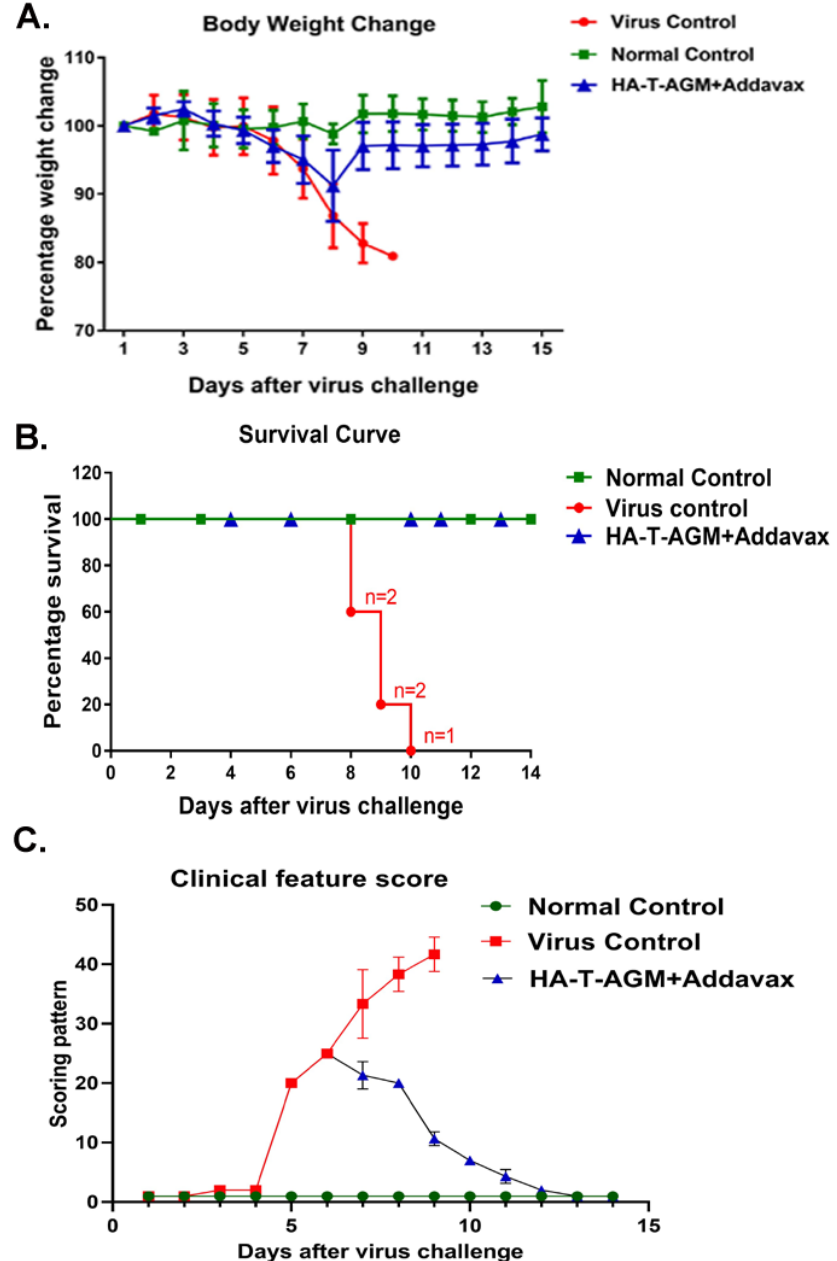
Figure 5. Protection by HA-T-AGM antigen against virus challenge. ( A ): Weight change in immunized mice followed for 14 days post virus challenge (Inf A/Puerto Rico/8/34 (PR8)), and comparison made to the immunized vs. non-immunized (virus control) group along with normal naïve control mice group. ( B ): Survival curve showing the number of dead mice after virus exposure with days passing. ( C ): The animals were scored from day 1 to day 14 after the virus challenge. The scoring scheme followed from 1 – 10 where 1 shows NAD (No abnormality), 2 was D (Dull), 3 was MP (Mild piloerection), 4 was PE (Piloerection), 5 was RFD (Reduction in food intake), 6 was reduced movement, huddling (RMH) 7 was H (Hunched), 8 was S (Shivering), 9 was SS (Severe shivering) and 10 represents HLI (Hind limb injury).